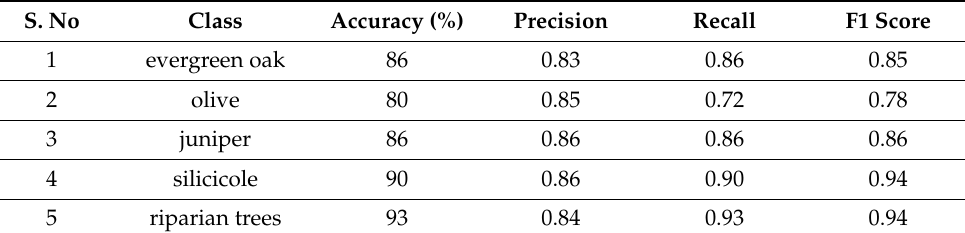
Table 3. Validation Metrics, Correlation Coefficients, and Mean Tree Canopy Temperatures for Different Tree Types.